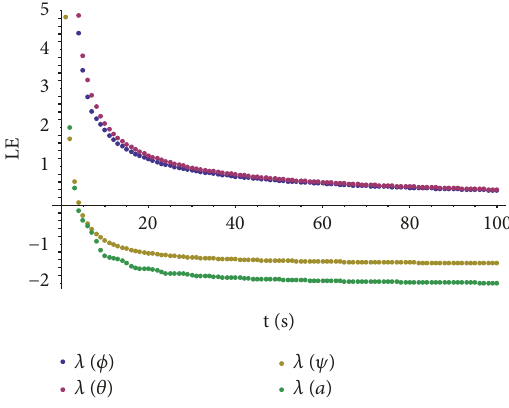
Figure 3: Lyapunov exponents spectrum of the MUAV ( a